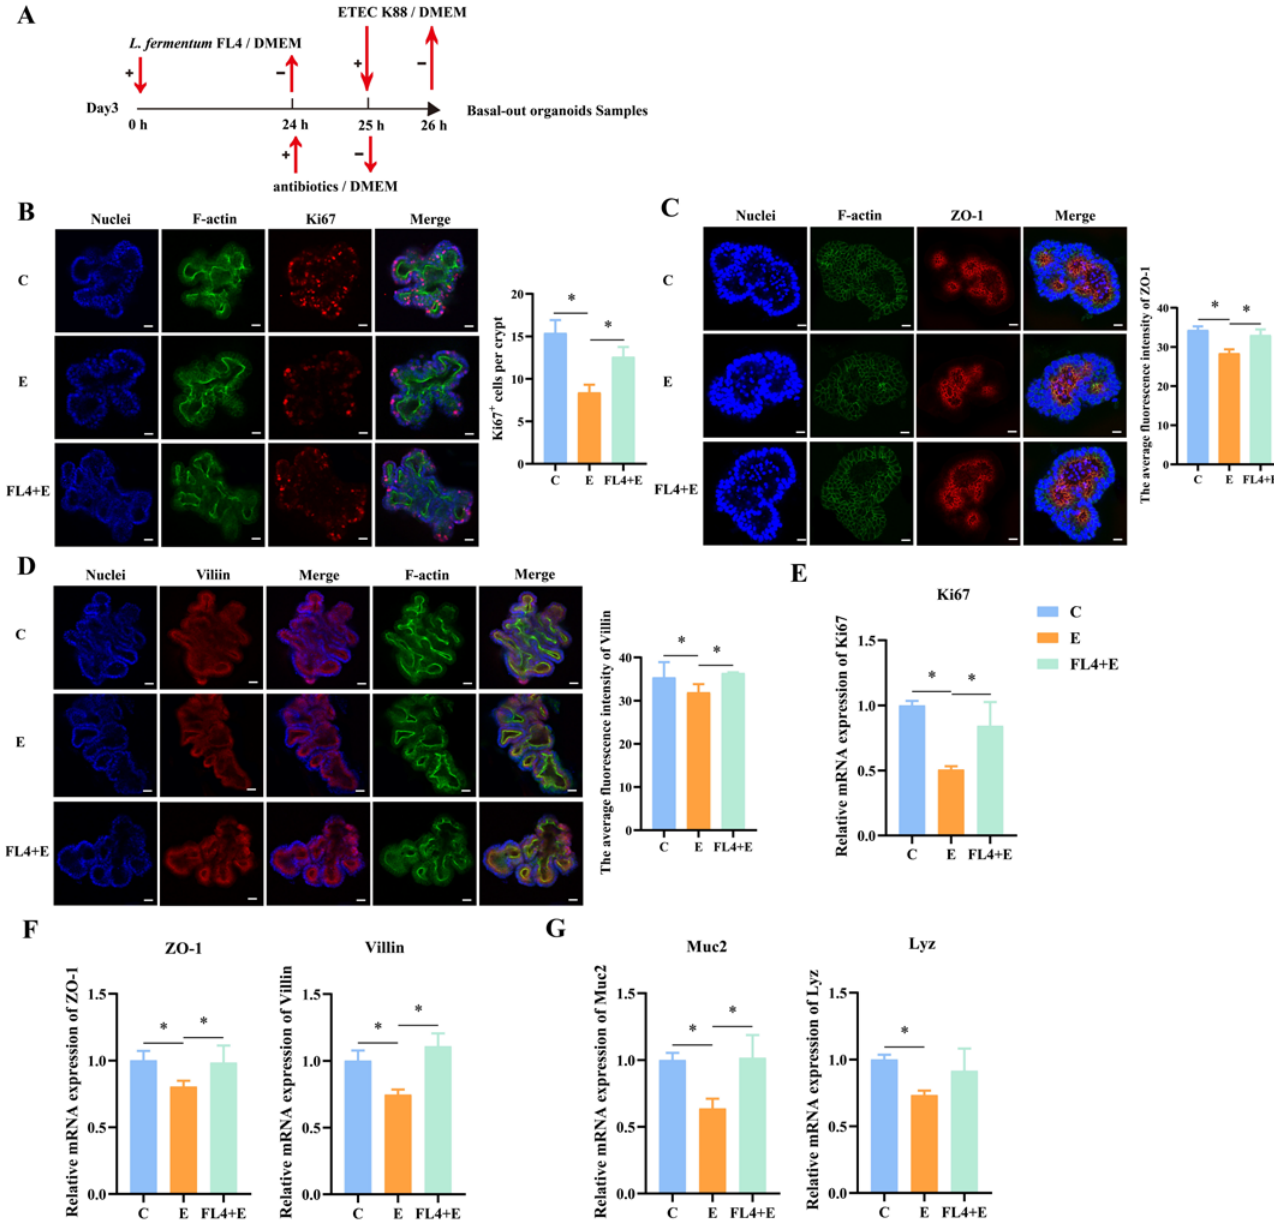
Figure 5. L. fermentum FL4 alleviated the intestinal epithelial damage induced by ETEC K88 in basal-out intestinal organoids. ( A ) Experimental procedure: basal-out organoids were treated with 10 6 CFU/well L. fermentum FL4 at 0 h (Day 3) and then supplemented with antibiotics at 24 h. The organoids were further challenged with 10 6 CFU/well ETEC K88 and the samples were collected at 26 hours. ( B – D ) Basal-out organoids were stained with Ki67, ZO-1, Villin (red). Nuclei were stained with 4 ′ ,6-diamidino-2-phenylindole (DAPI, blue), cytoskeletons were stained with F-actin (green). Scale bars, 20 µm. ( E ) RT-qPCR analysis of the Ki67 in organoids, n = 3. ( F , G ) RT-qPCR analysis of the ZO-1, Villin, Muc2 and lysozyme (Lyz) in organoids, n = 3. * p < 0.05.